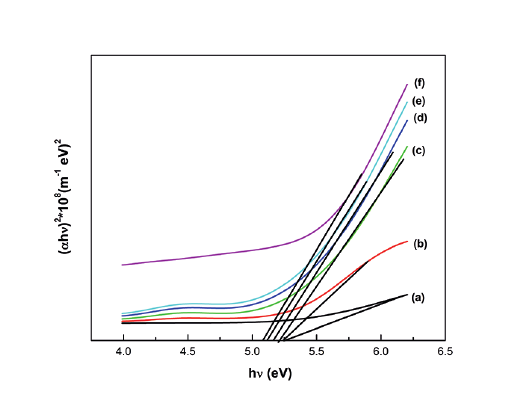
Figure 7: (αhν) 2 vs hν plots of pure and Mn 2+ doped PVC polymer films (a) Pure (b) 1mol % (c) 2 mol % (d) 3 mol % (e) 4 mol% (f) 5